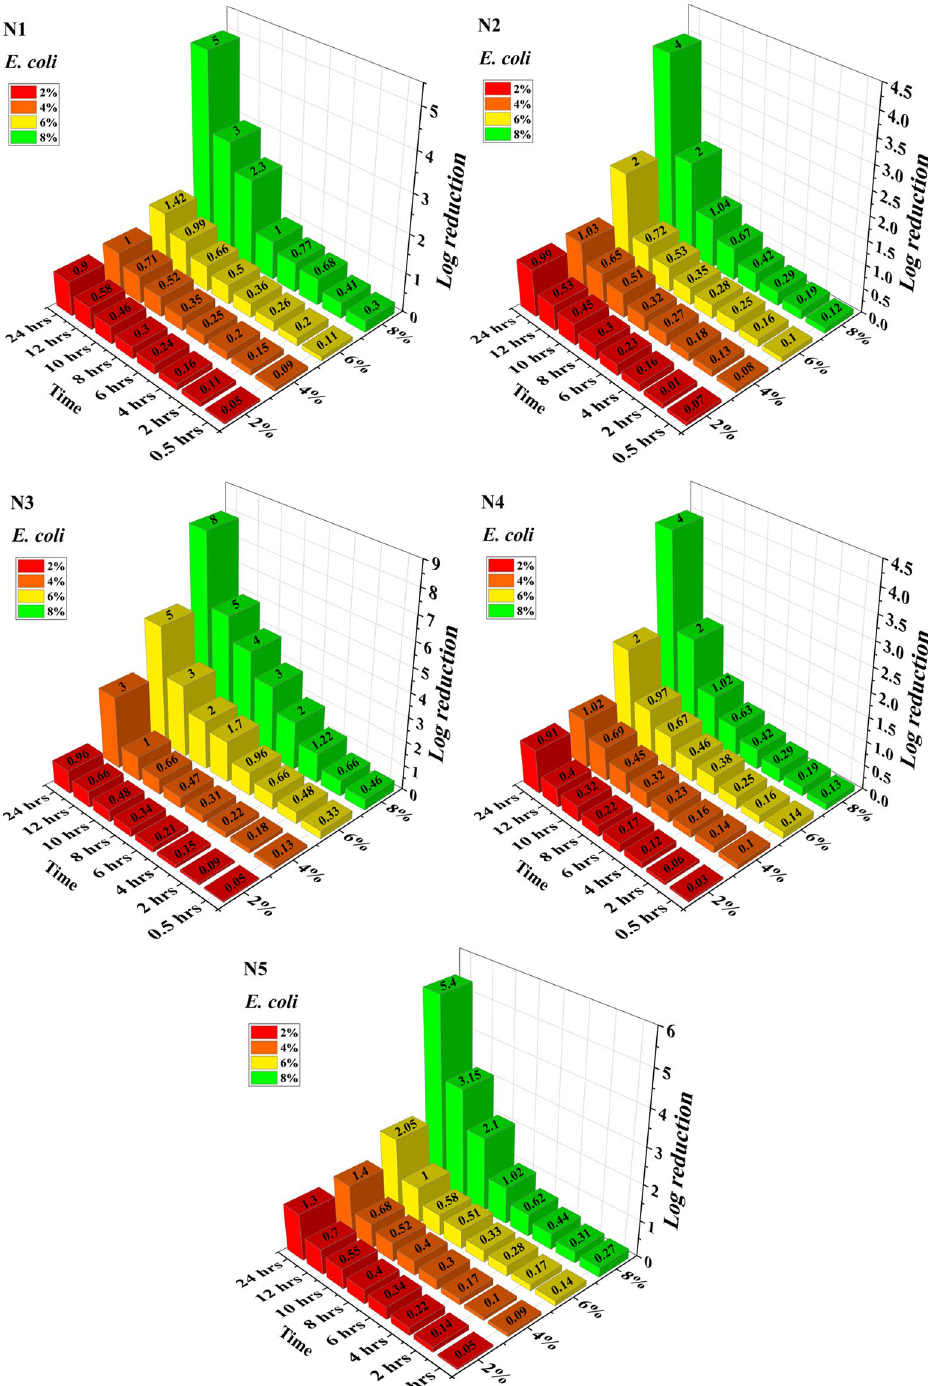
Figure 8. Log reduction of E. coli by acrylonitrile